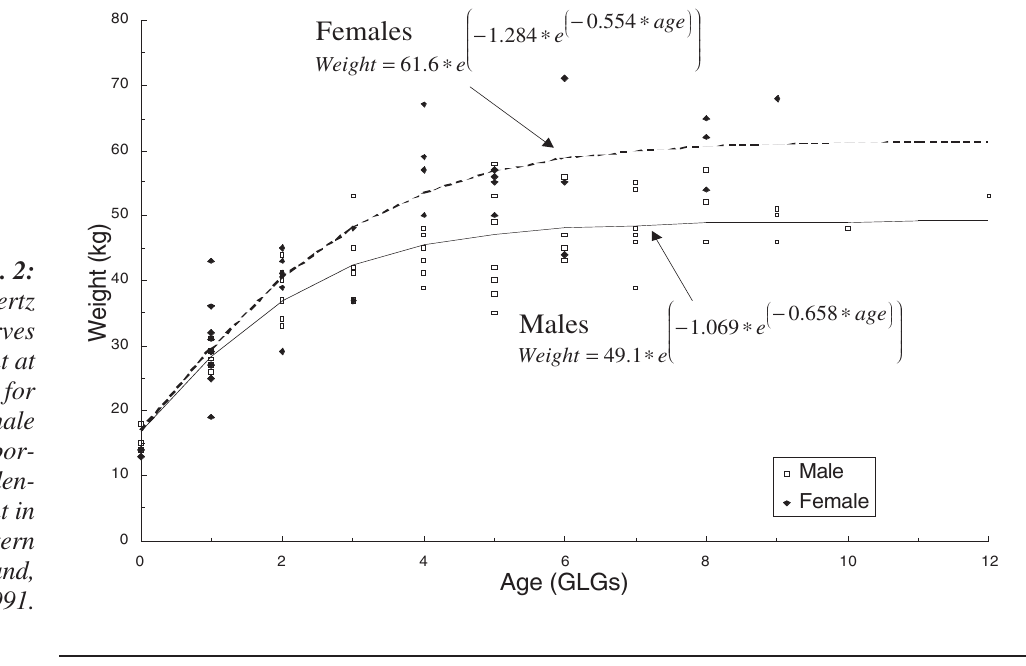
Fig. 2: Gompertz growth curves fit to weight at age data for male and female harbour por- poises inciden- tally caught in eastern Newfoundland,